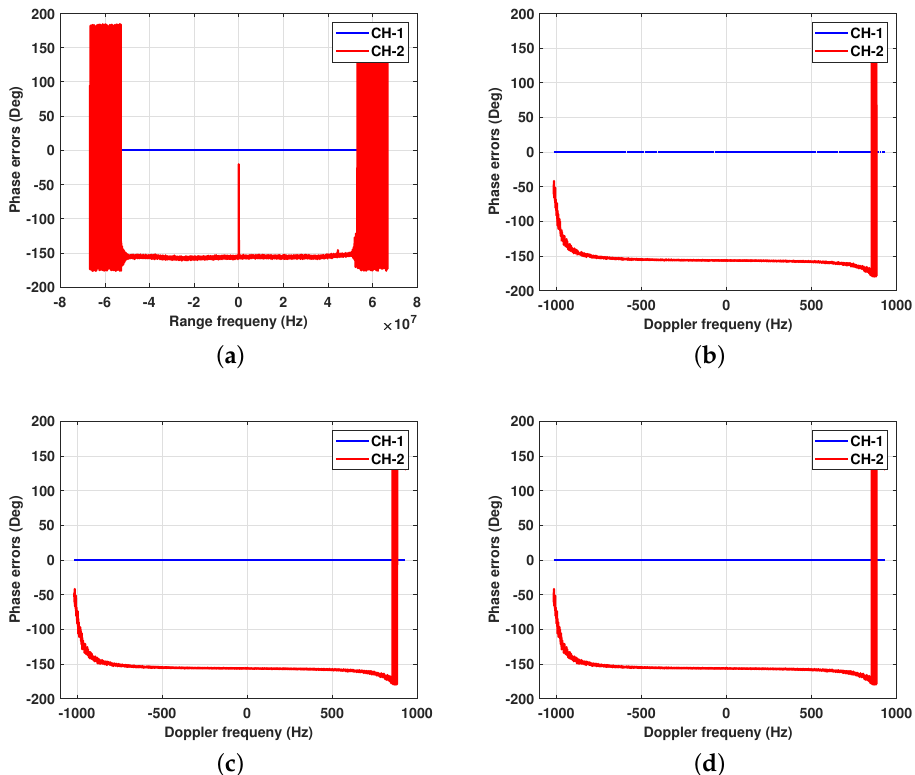
Figure 12. The results of channel phase error estimation of the GF − 3 dual − channel mode. ( a ) Estimated result using the TDCM. ( b ) Estimated result using the OSM. ( c ) Estimated result using the MVDR. ( d ) Estimated result using the proposed method.